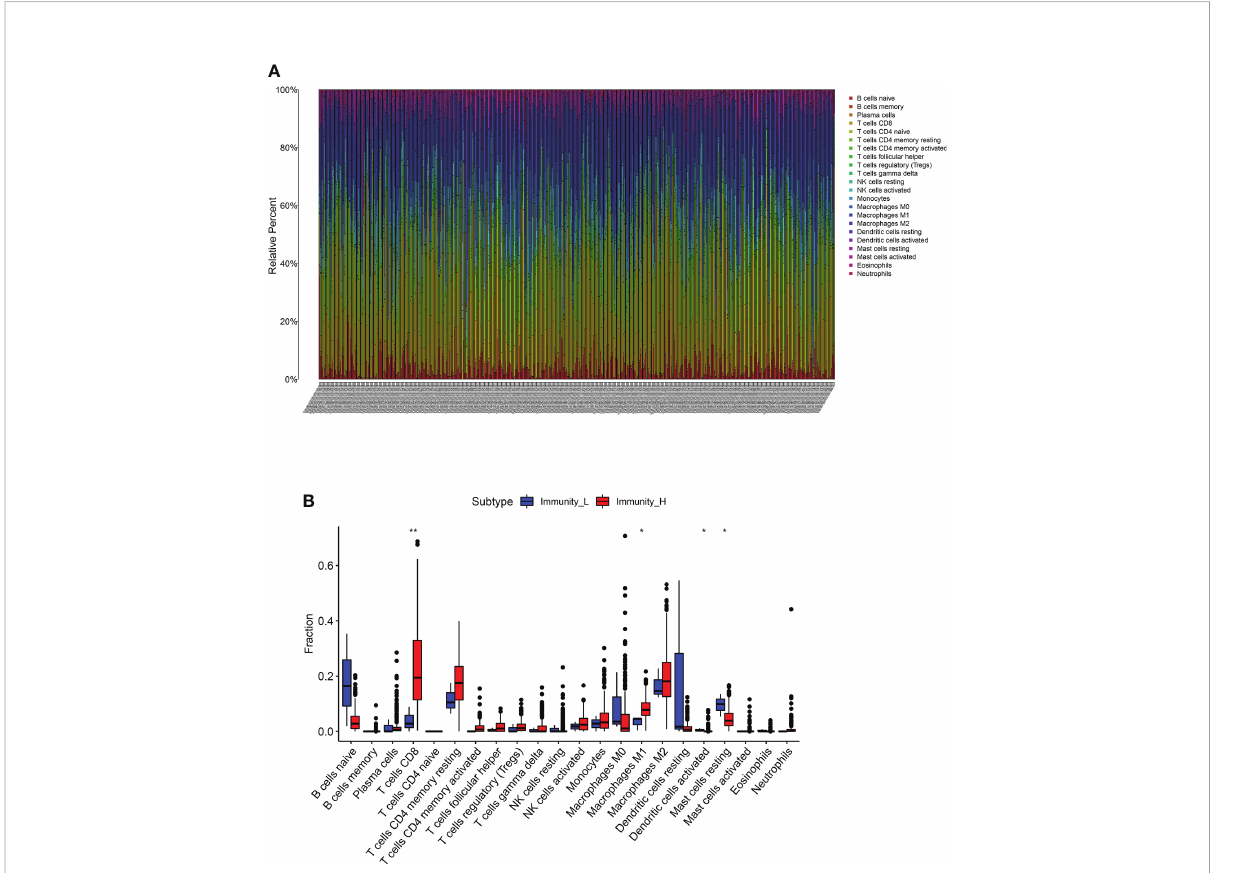
FIGURE 3 (A, B) The different expression of immune cells between immune_H and immune_L groups ** P < 0.01; * P <